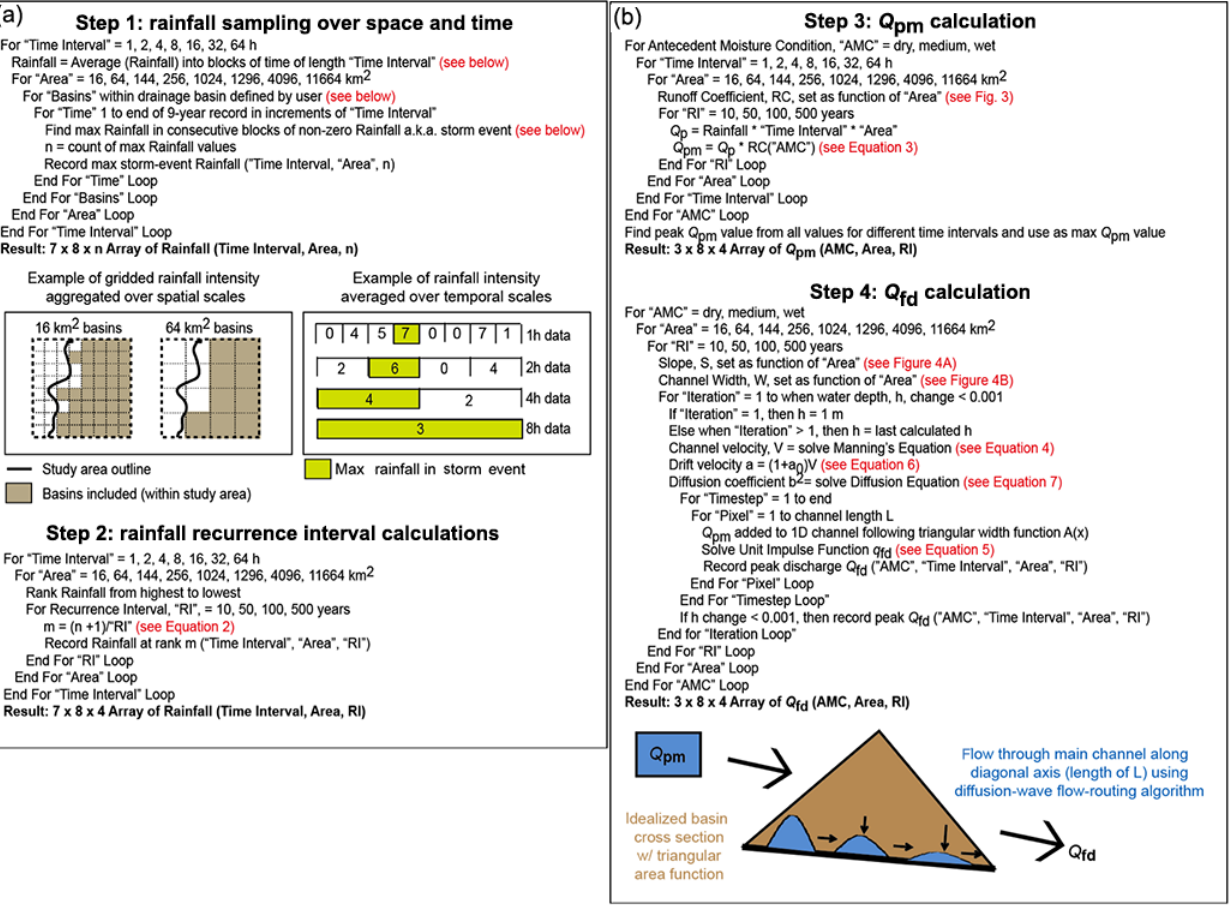
Figure 2. (a) Pseudocode describing the methods of the paper with schematic diagrams shown below pseudocode in some cases. Equations within the text and other figures are referenced in red text. (b) Pseudocode describing the methods of the paper with schematic diagrams shown below pseudocode in some cases. Equations within the text and other figures are referenced in red